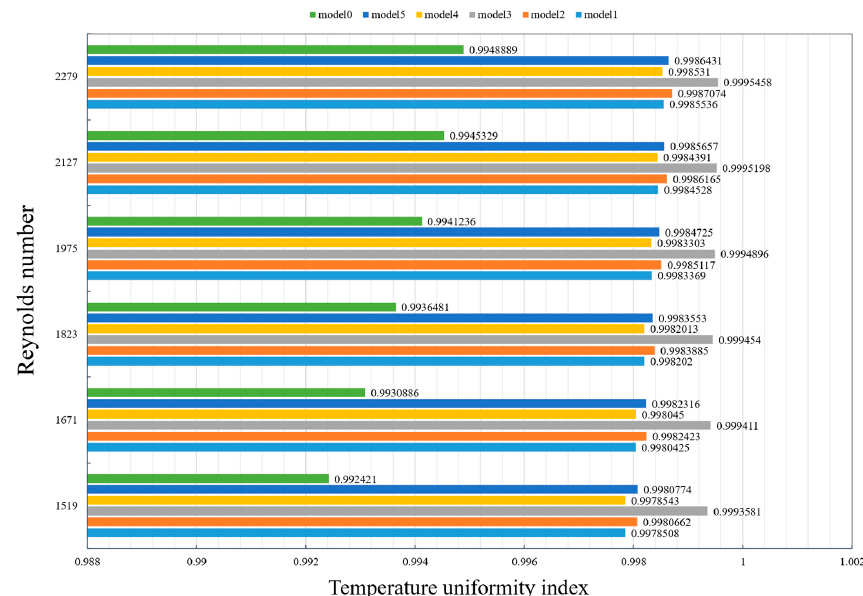
Figure 13. Effect of Reynolds number on temperature uniformity